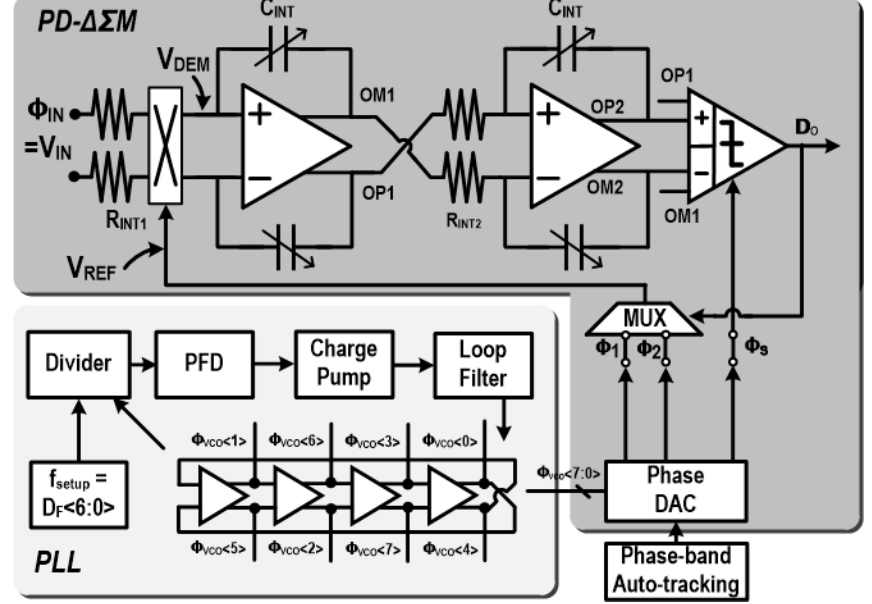
Figure 3. Circuit-level implementation of PLL and PD- ΔΣ M.